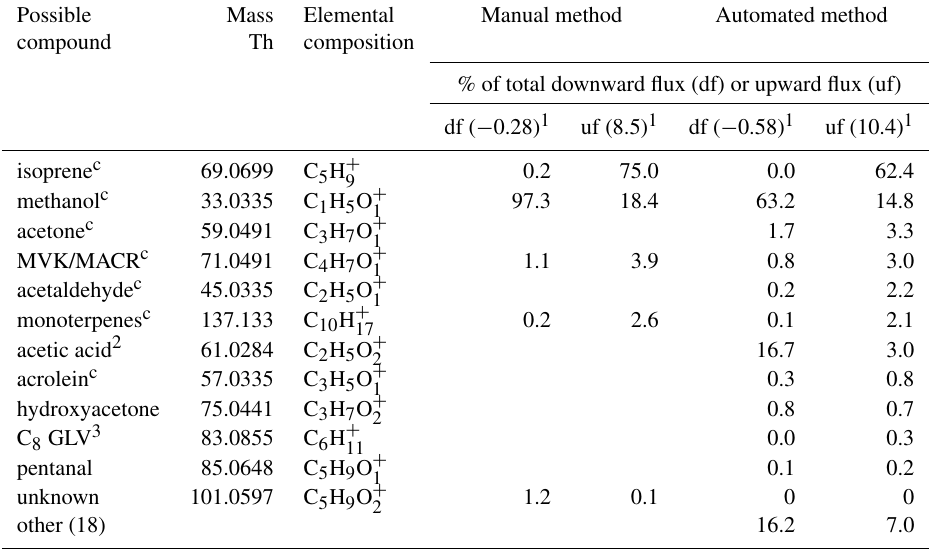
Table 2. Downward flux (df) and upward flux (uf) calculated with different methods. The individual compounds listed under automated are for a 10 σ noise threshold, the remaining compounds (between 3 and 10 σ noise ) are summed up under “other”. Possible Mass Elemental Manual method